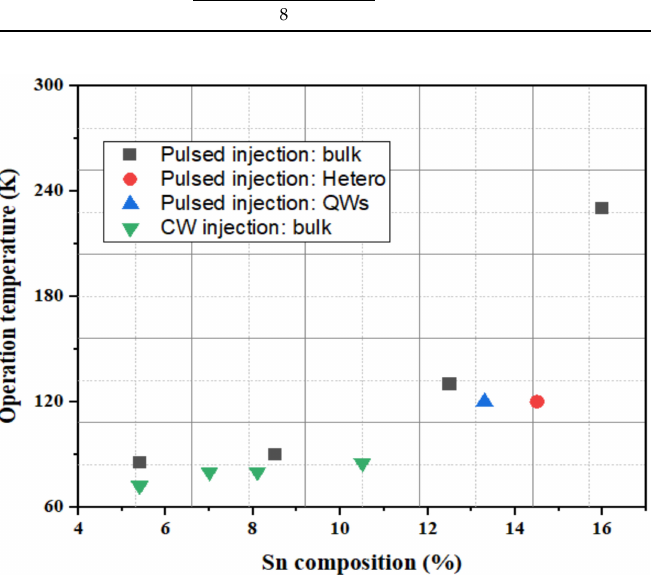
Figure 33. Maximum operation temperature vs. Sn content for an optically pumped WGM cavity GeSn laser (under pulsed 1064 nm